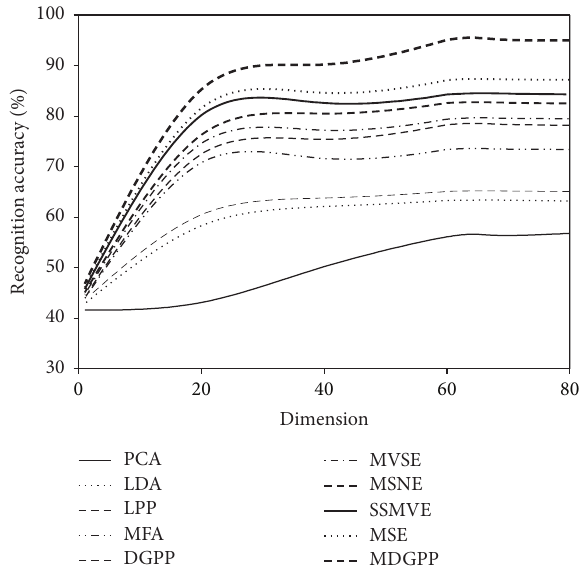
Figure 5: Recognition accuracy versus reduced dimension on the CMU PIE database.